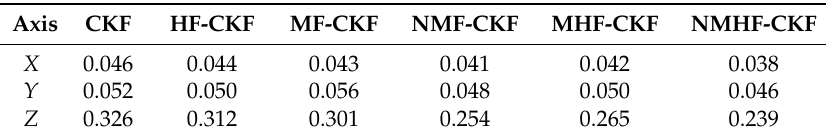
Table 5. Attitude RMSEs of each scheme